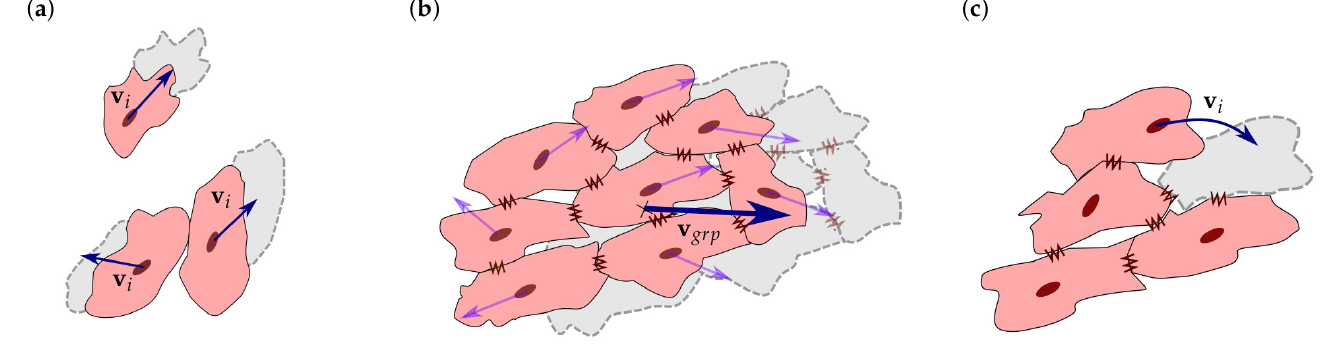
Figure 3. Cell migration and interaction. ( a ) Individual cell migration. v i is considered for individual cells and for cells that are not attached to any other cell. ( b ) Collective cell migration is considered for groups of cells that are attached by cell junctions. Group velocity, v grp , is defined on the basis of the migratory tendency of the individual cells of the group. ( c ) Cell relocation is considered when group velocity is insufficient to consider group movement. Any internal cell can migrate to a more favorable position with its individual velocity, v i , without detaching the